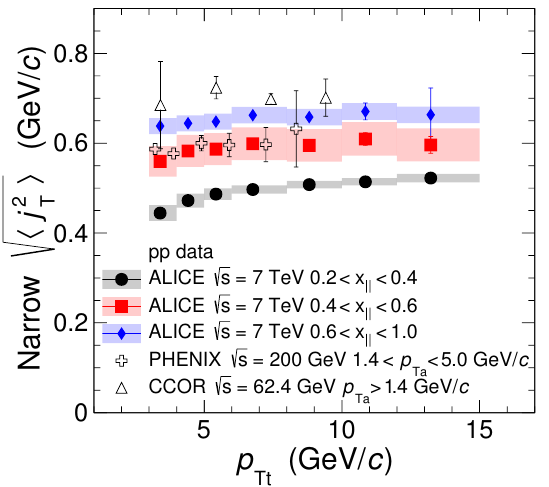
Figure 8 . Narrow component RMS in di(cid:11)erent x component results from PHENIX [6] and CCOR